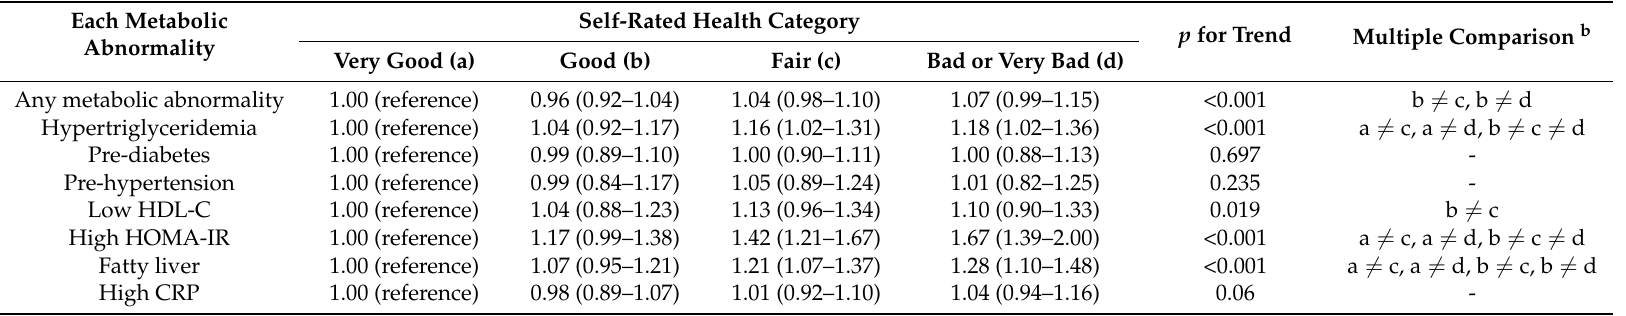
Table A2. Hazard ratios (95% CI) a for each metabolic abnormality by self-rated health category with multiple